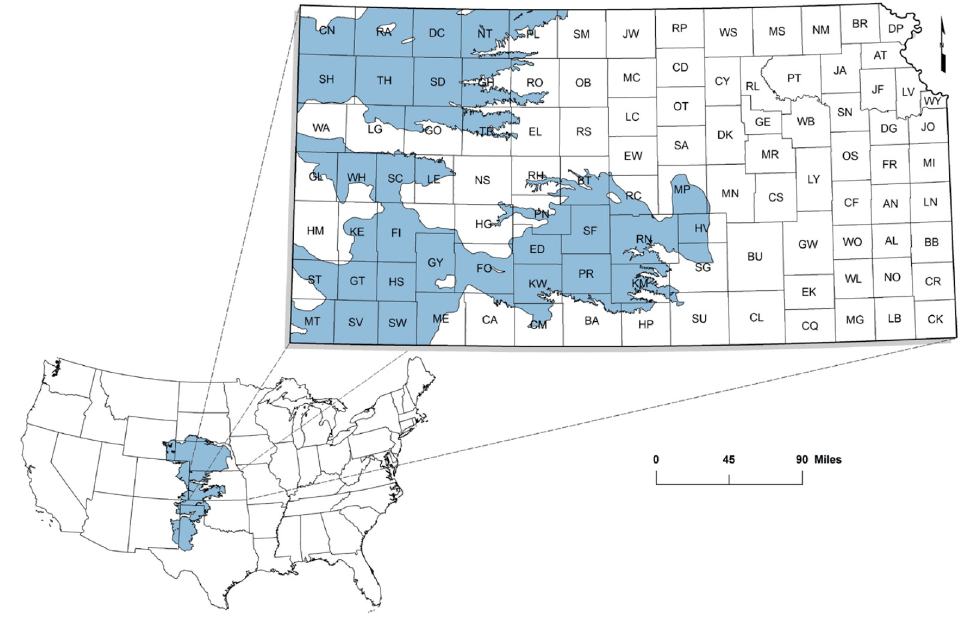
Figure 1. The High Plains aquifer [9].